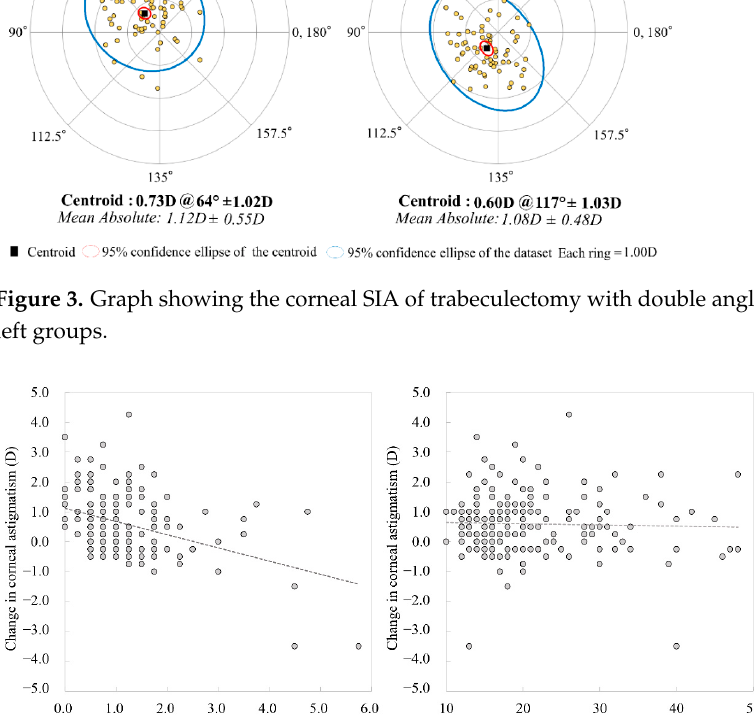
Figure 4. Graphs showing a significant correlation of the M-SIA with the preoperative corneal astigmatism (Pearson correlation coefficient r = − 0.308, p < 0.001), but not with the preoperative intraocular pressure ( r = − 0.017, p = 0.823).